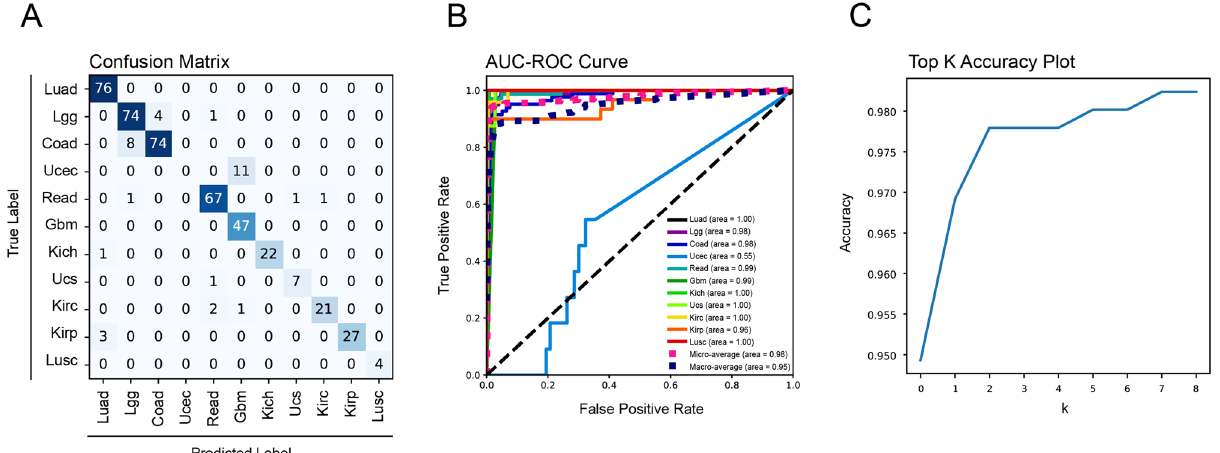
Figure 4. Performance of neoplastic subtype classifier. ( A ) Confusion matrix of tissue origin classifier; ( B ) Receiver operating characteristic curve (ROC) with area under the curve (AUC); ( C ) top K accuracy